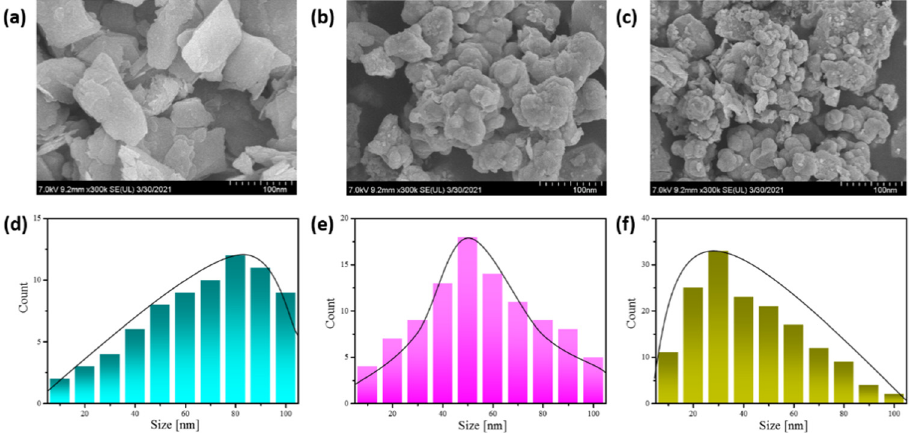
Figure 2. SEM images of WSe 2 NSs ( a ) NS1 (6 h sonication), ( b ) NS2 (12 h sonication), and ( c ) NS3 (18 h sonication); ( d – f ) particle size distribution of WSe 2 NSs ( d ) NS1 (6 h sonication), ( e ) NS2 (12 h sonication) and ( f ) NS3 (18 h sonication).